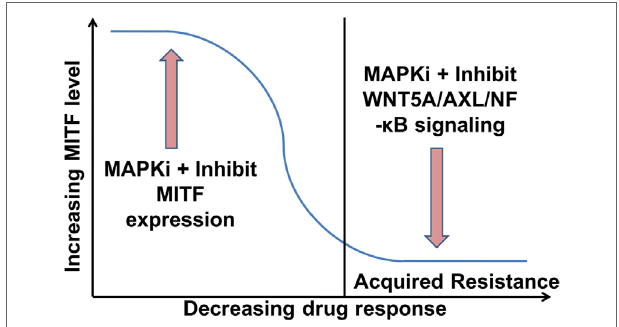
FiGURe 2 | Proposed role of microphthalmia-associated transcription factor (MITF) and WNT5A/AXL/NF- κ B signaling in melanoma therapy. MITF high melanomas could be treated initially with a combination of an MAPK pathway inhibitors (MAPKi) and an inhibitor of MITF expression. This should increase the efficacy of the MAPKi and delay the acquisition of drug resistance (104). Once in the resistance state with low MITF levels, the therapy could comprise a combination of a MAPKi and an inhibitor of WNT5A/AXL/NF- κ B